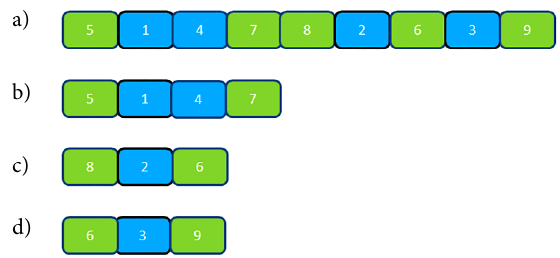
Fig. 4. Routes: a – assignment route; b–d – elementary assignment routes (source: created by